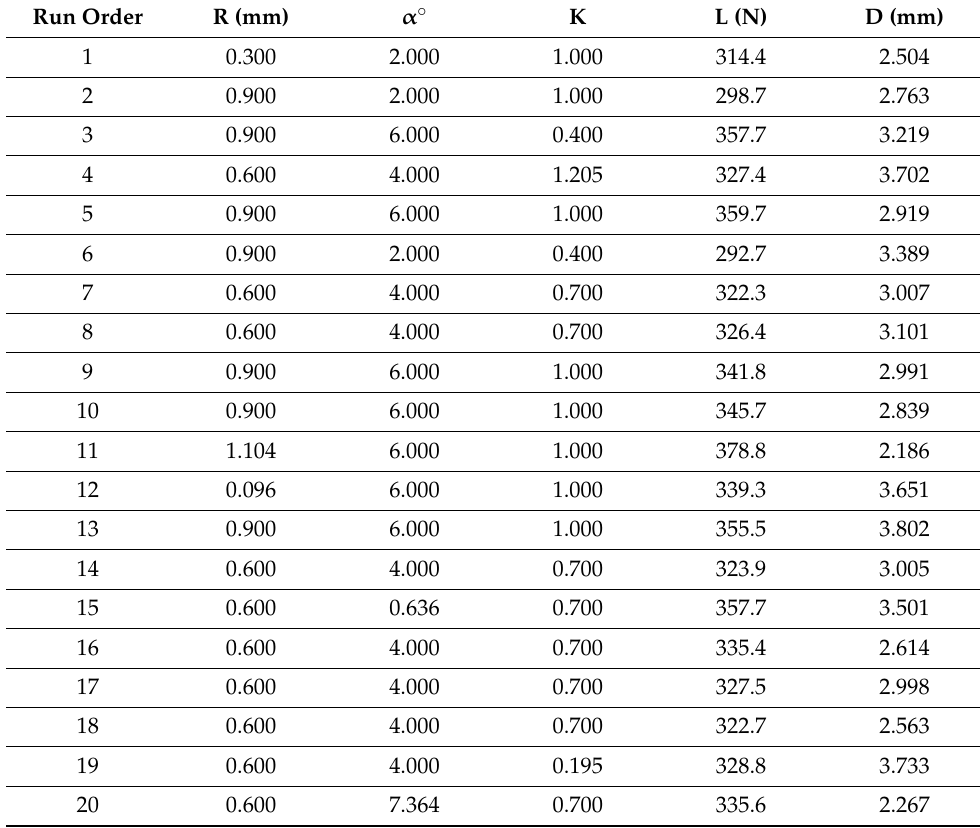
Table 4. Force (L) and displacement (D) values obtained after testing new parts. Run Order R (mm) α